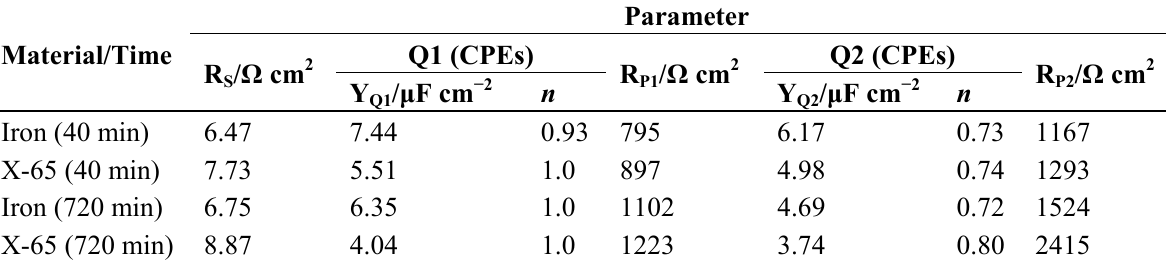
Table 2. EIS parameters obtained by fitting the Nyquist plots shown in Figures 6 and 7 with the equivalent circuit shown in Figure 8 for iron and API X-65 steel after 1 and 12